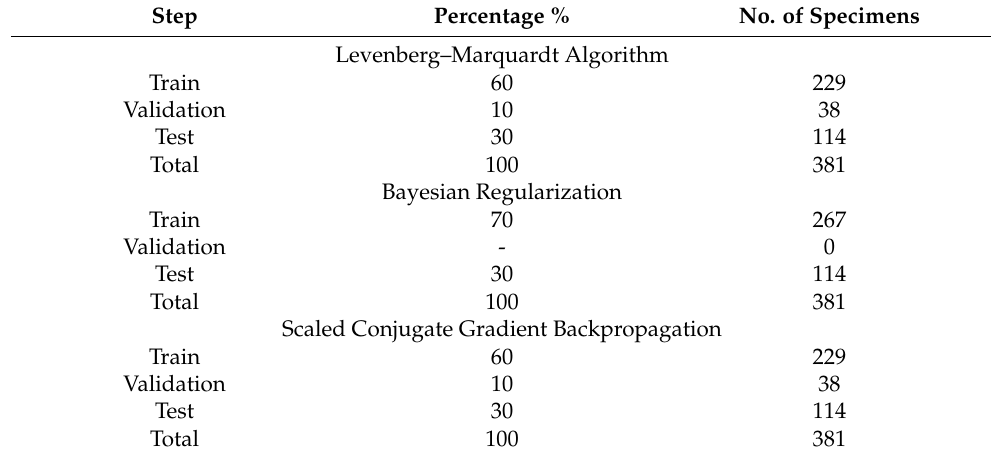
Table 3. Data split for model testing.